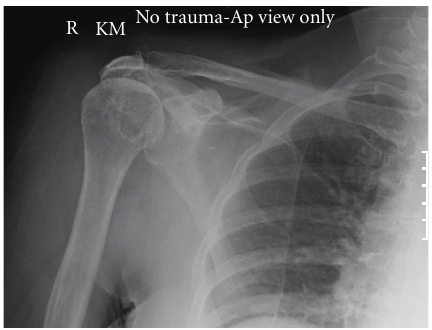
Figure 1: Anterior-posterior radiograph of the right shoulder at admission.